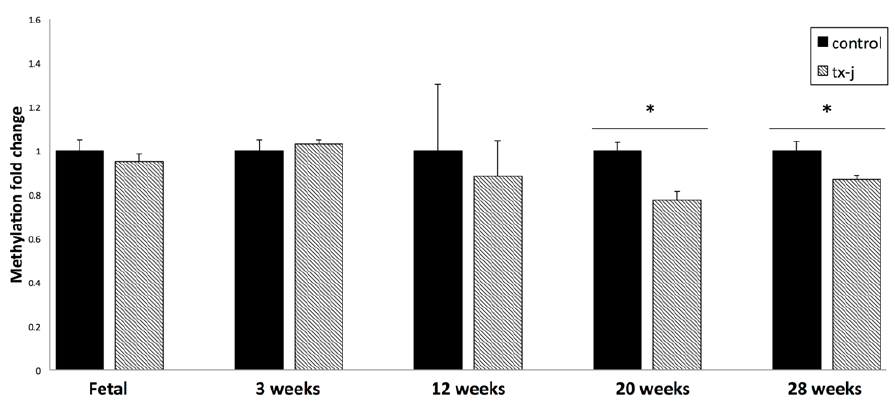
Figure 5. Hepatic global DNA methylation. Values with * are significantly different ( p < 0.05) between tx-j vs . control within each time point. Values are expressed as fold change ± SD. Fetal and three weeks data were previously published